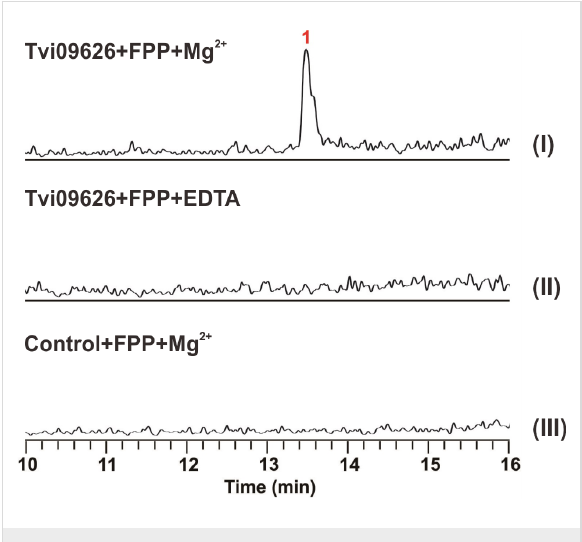
Figure 5: GC–MS chromatogram for the metal ion dependency